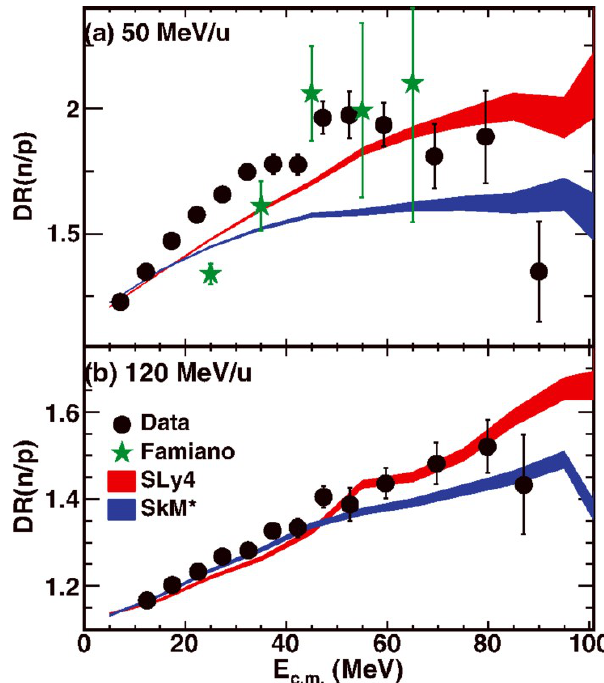
Figure 7. (Color on-line) Double ratios (DRs) of neutron over proton yields in reactions of 124 Sn + 124 Sn over 112 Sn + 112 Sn at energies of 50 and 120 AMeV as a function of the center-of-mass energy of the emitted particles. The experimental data represent coalescence-invariant cross-sections, for which neutrons and protons of all experimentally measured clusters with A 4 are included. The calculations ≤ are Boltzmann–Uehling–Uhlenbeck (BUU) calculations with the two Skyrme-like functionals SKM and SLy4, which have a different ordering of the neutron and proton effective masses but are otherwise very similar; see text. The figure is taken from [42] with